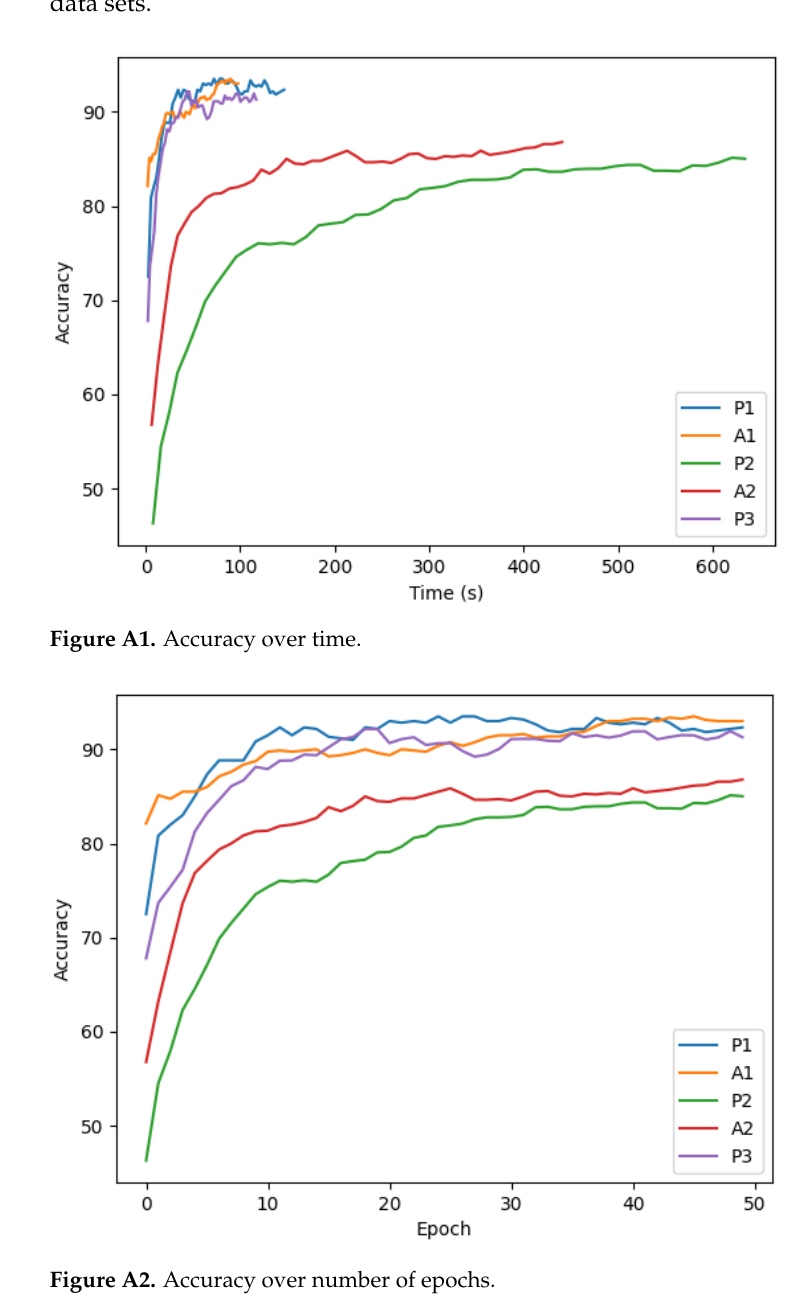
Figure A2. Accuracy over number of